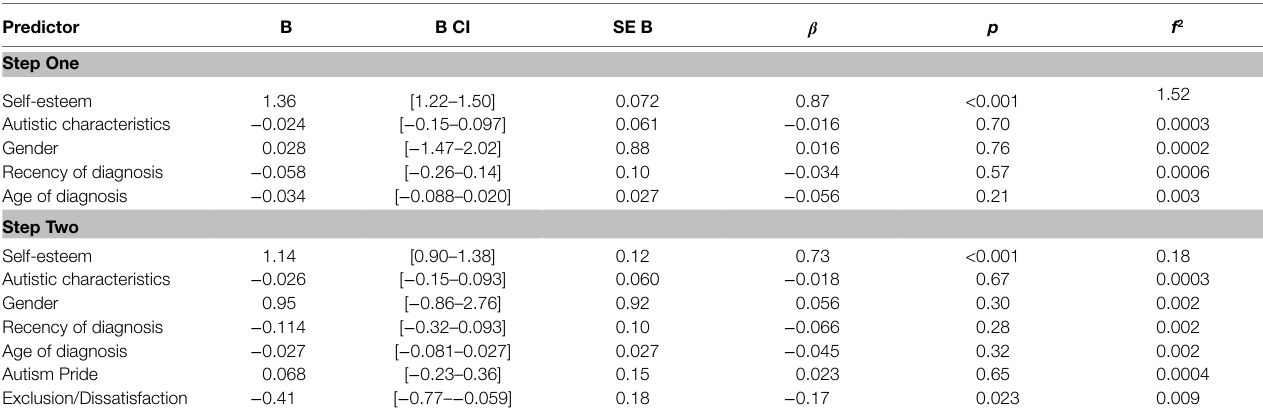
TABLE 6 | Hierarchical regression results, with wellbeing as the outcome variable. Predictor